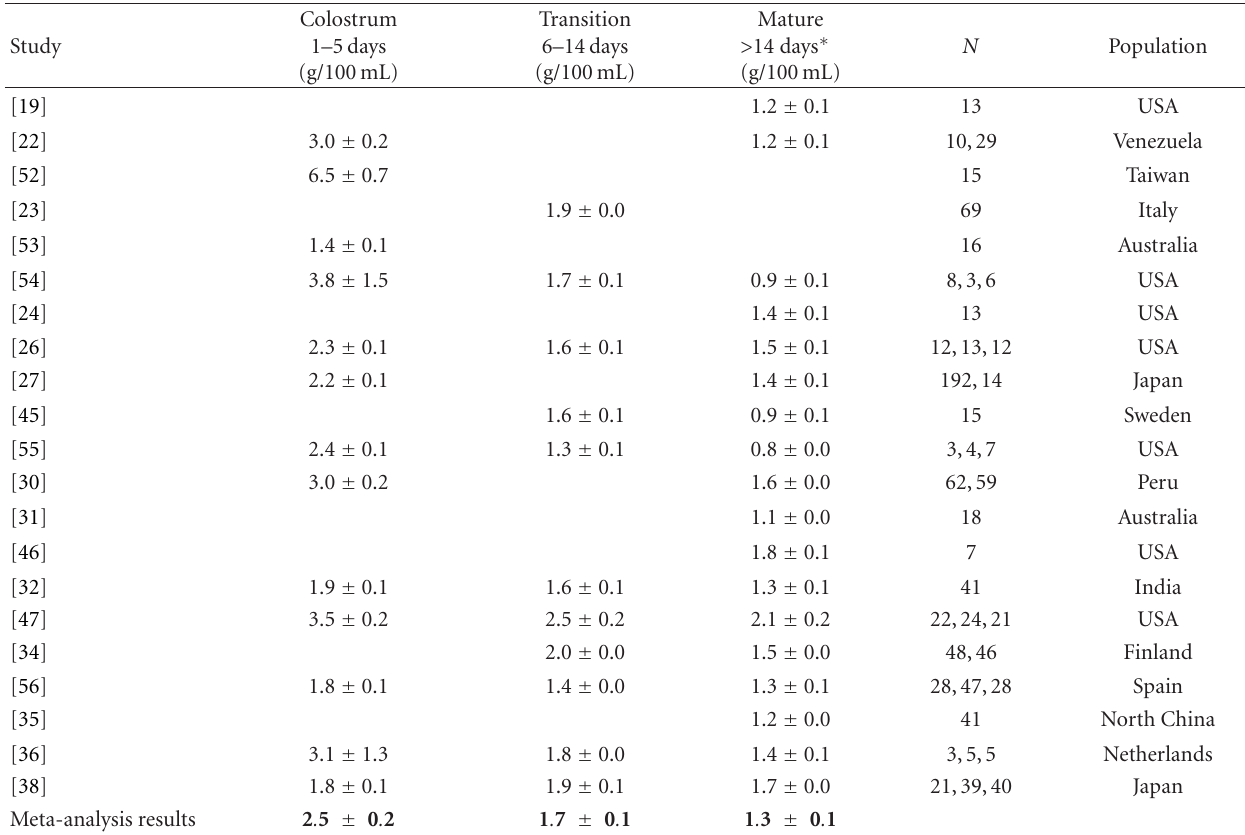
Table 4: Protein concentration in breast milk